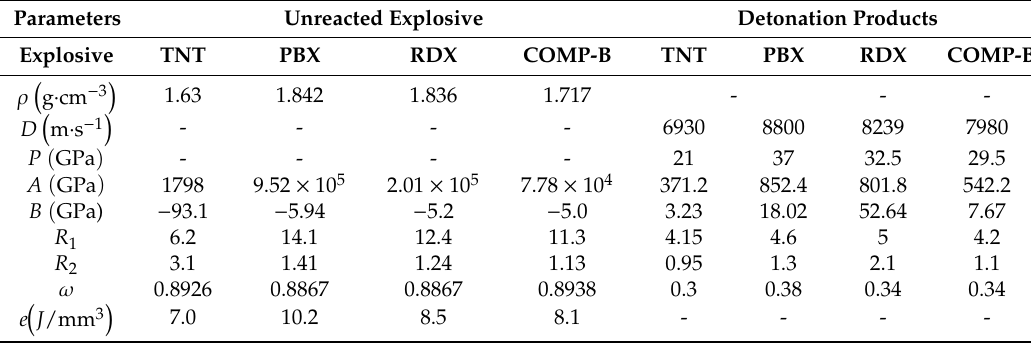
Table 1. JWL parameters of explosives (PBX, RDX, COMP-B and TNT).